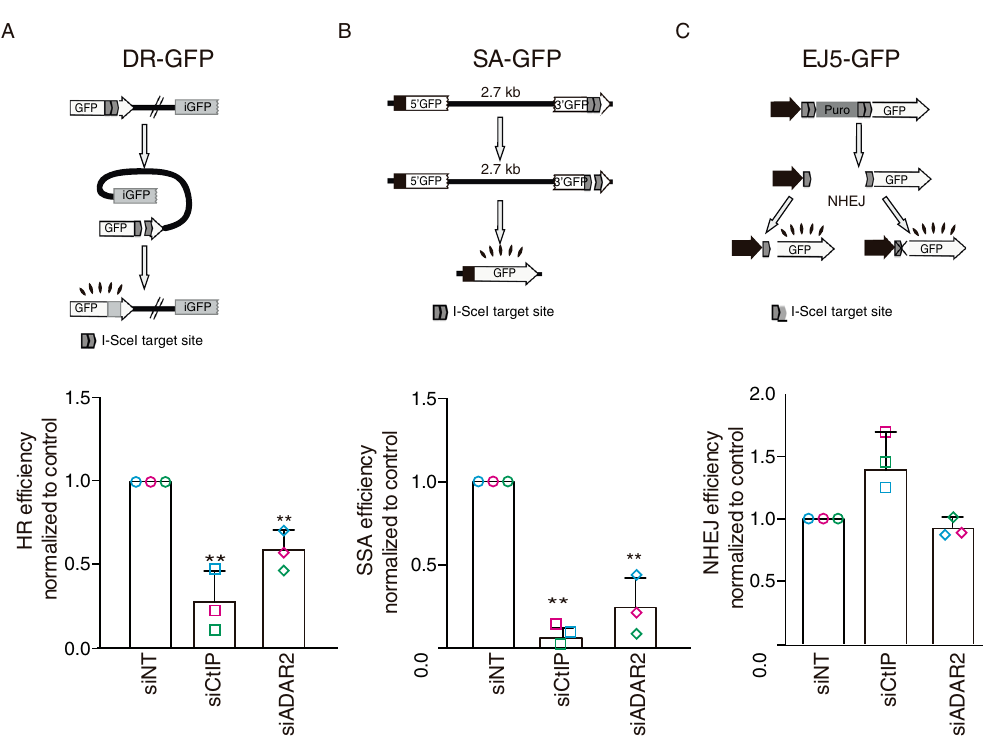
Fig. 3 ADAR2 depletion affects homologous recombination. A Effect of ADAR2 depletion in the DR-GFP reporter. A scheme of the reporter is shown on the top. Induction of a DSB using I-SceI meganuclease renders GFP-positive cells when the donor repeat (iGFP) is used in a gene conversion event. The ef fi ciency of classical recombination (HR) was calculated as the percentage of GFP-positive cells in response to I-SceI expression upon downregulation of the indicated genes and normalized with the control. The average and standard deviation of at least three independent experiments are shown. B Same as A but using the Single Strand Annealing (SSA) reporter SA-GFP (top). In this case, the induction of a DSB located between two repeats in direct orientation will render GFP-positive cells only when intramolecular SSA takes place. C Same as A but using the non-homologous end-joining (NHEJ) reporter EJ5-GFP (Top). In this case, two I-SceI-induced DSBs could be repaired by conservative or mutagenic NHEJ granting the accumulation of functional GFP. In all panels, the average and SD of three independent experiments are shown and statistical signi fi cance was determined with a two-tailed paired Student ’ s t -test. Each individual replica is marked with a colored symbol. One, two, or three asterisks represent p < 0.05, p < 0.01, or p < 0.001, respectively. Actual p -values can be found in the Source data fi le. Only biological relevant comparisons are